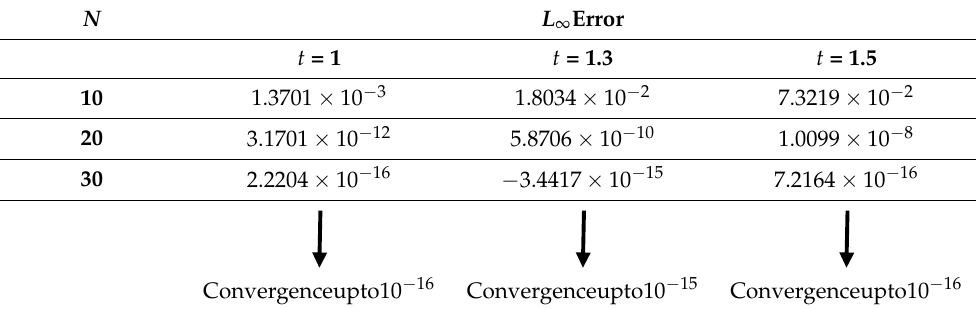
Table 4. Error analysis regarding Example 1.